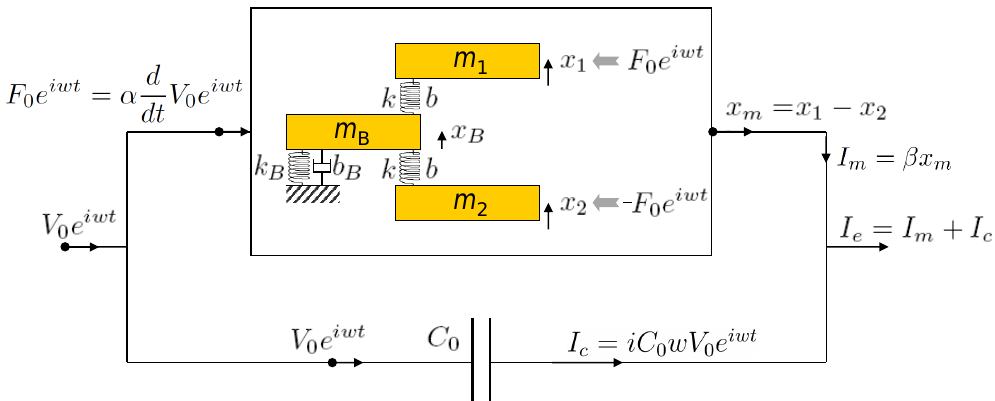
Figure 4. Electromechanical model for an electrically driven tuning fork. The input voltage V 0 e iwt effectively generates the mechanical force F 0 e iwt , given as i α wV 0 e iwt , where α is the constant that converts applied electrical voltage to mechanical force. The force actuates the two prongs of the tuning fork, and the geometrical displacement of the two prongs x m = x 1 − x 2 induces the electrical current I m = β x m , where β is the converting factor. In addition, the input voltage induces the stray capacitance current I c . The measured current I e is given by the sum of the motion-induced current and the